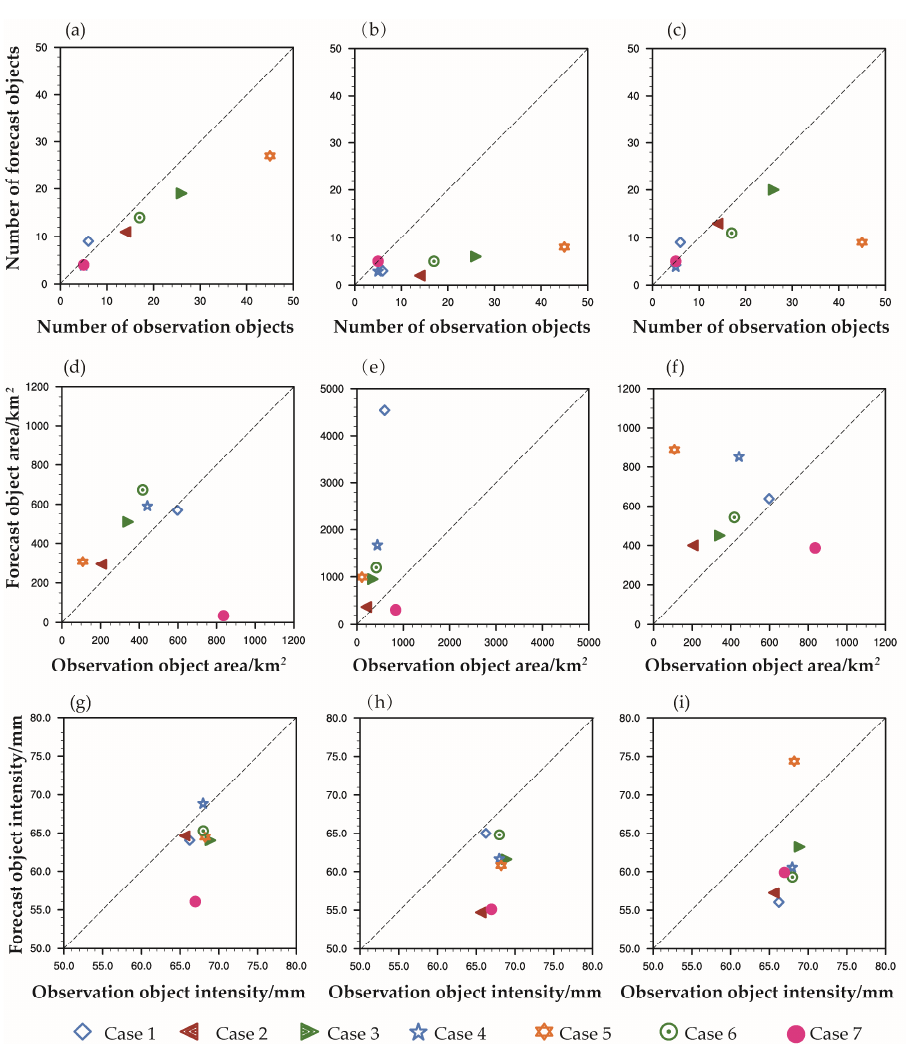
Figure 3. The number, area, and intensity of precipitation objects verified by the MODE method of three precipitation forecast products and observe precipitation for 7 rainstorm cases of 2020. ( a – c ) are the number of objects. ( d – f ) are objects area. ( g – i ) are objects intensity. The precipitation intensity of seven rainstorm cases was analyzed (Figure 3 bottom row). To comprehensively show the overall intensity of precipitation, 90% quantiles of precipitation greater than 50.0 mm were selected for analysis to remove the possible extreme precipitation at a single grid. It can be seen that ECMWF still has a good forecast performance in terms of intensity forecast. Excluding the seventh rainstorm case, the other rainstorm intensity forecast and observation values are basically similar. However, SCMOC and CMA-Meso were generally weak (Figure 3h), with no obvious advantage over ECMWF. The TS scores of ECMWF, SCMOC and CMA-Meso are 0.216, 0.227 and 0.193, respectively, and SCMOC has the largest TS score, but this does not mean that SCMOC has the best forecast and early warning ability. A mode test shows that the number of